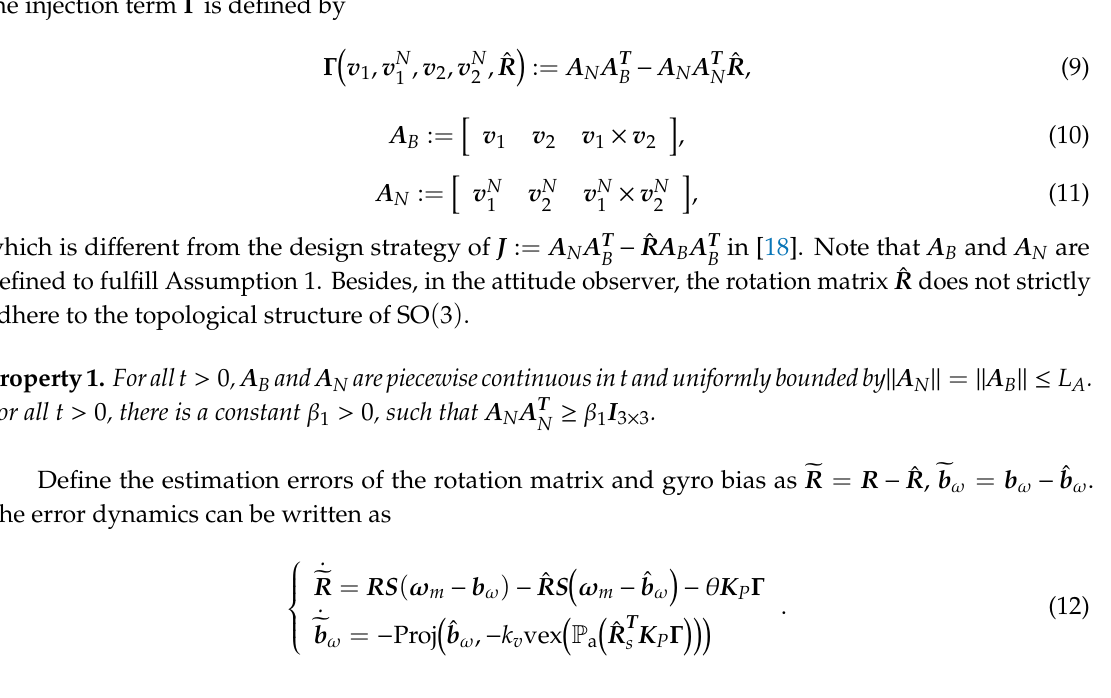
Figure 1. Overall structure of the total observer.  auxiliary